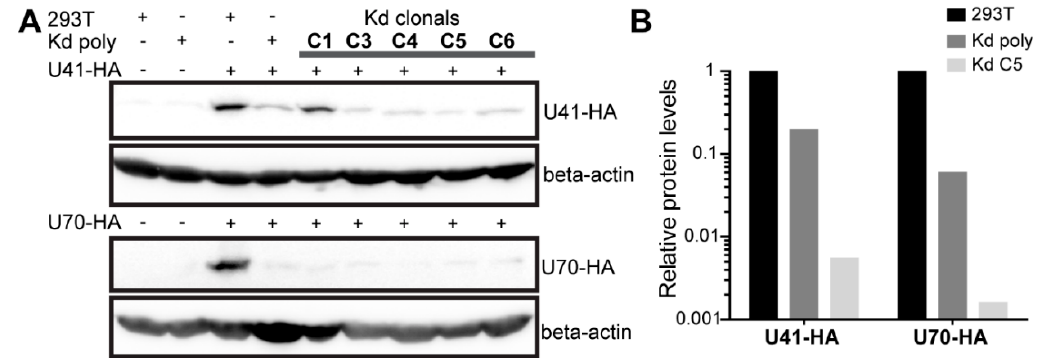
Figure 2. Validation of 293T HHV-6A U41/U70 knockdown cells. ( A ) 293T, Kd poly or single cell clones were individually transfected with U41-HA (upper panels) or U70-HA (lower panels) expression plasmids. One day post-transfection, cells were lysed and the proteins separated by SDS-PAGE. Immunoblotting was then performed using anti-HA or anti-beta-actin (beta-actin; loading control) antibodies. ( B ) Optical densities for HA bands were extracted using BIO-1D software and normalized for protein loading ( β -actin). Displayed in the histogram is the viral protein expression in the poly clonal cells (Kd poly) and the best clonal cell (Kd C5) relative to expression in 293T control cells.